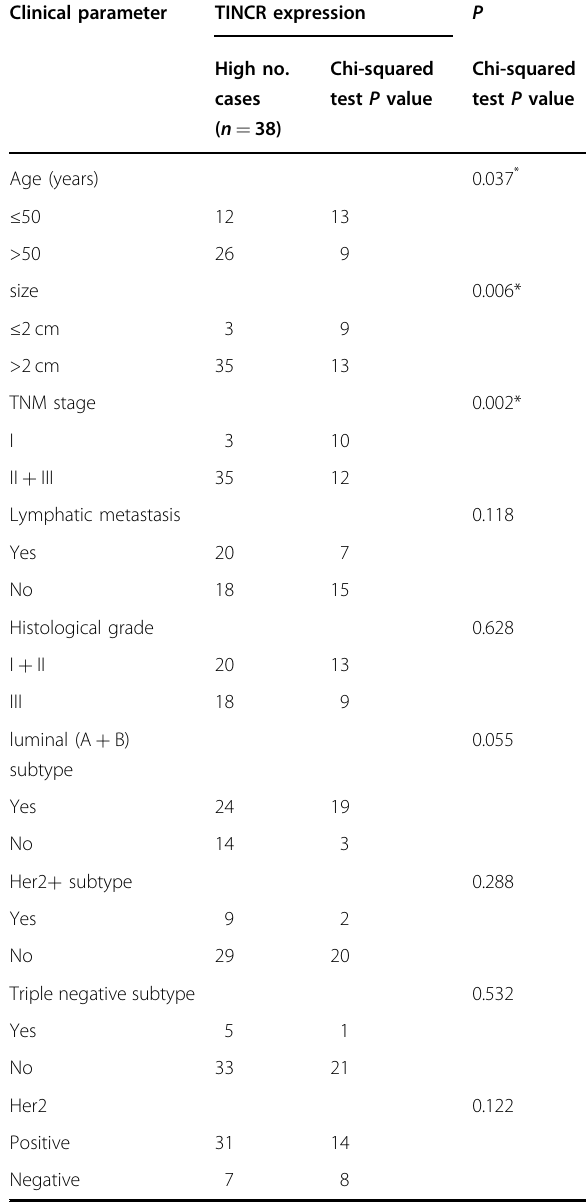
Table 1 Correlation between TINCR expression and clinicopathological characteristics of breast cancer. Clinical